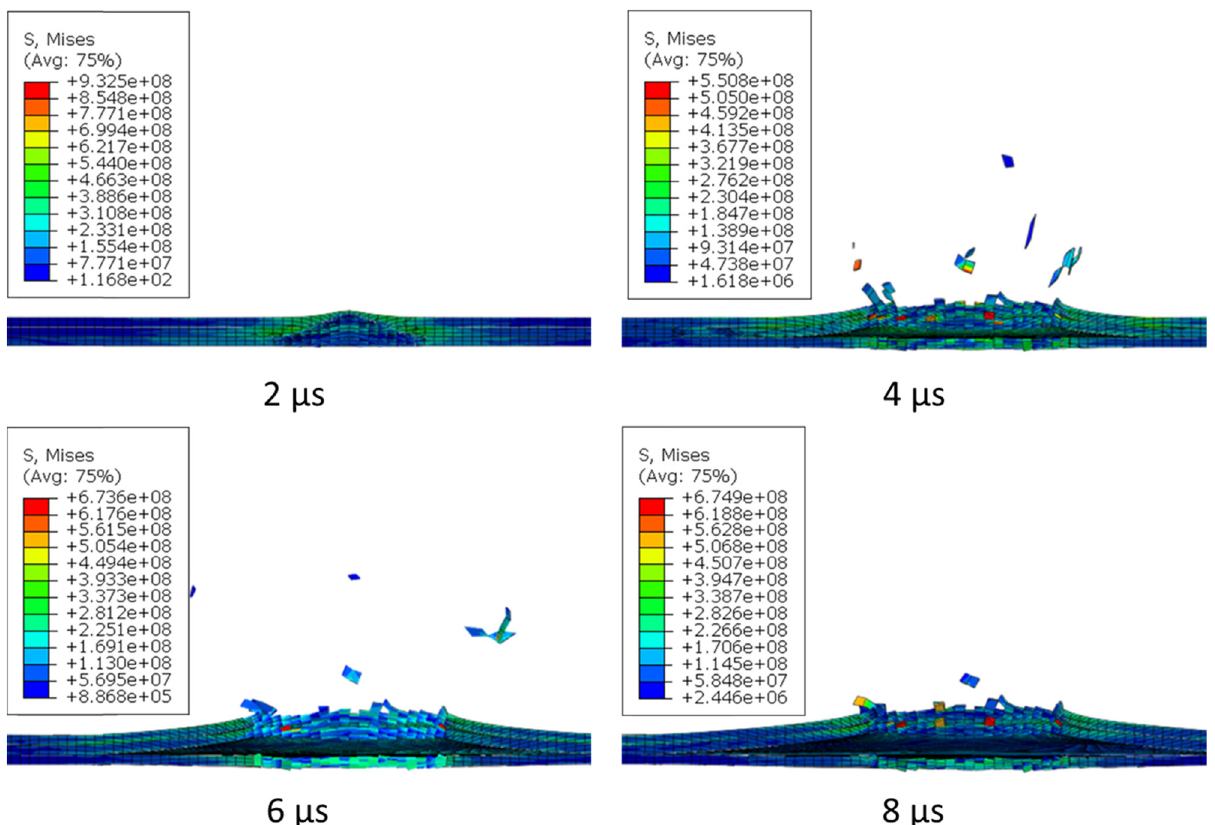
Figure 12: Stress distribution and deformation for model 3 against hemispherical